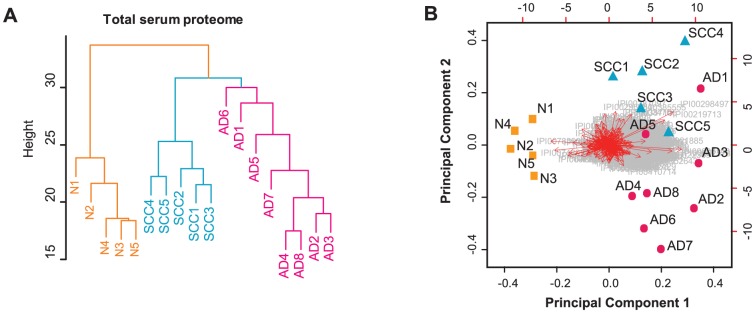
HCA and PCA of total serum proteomic data between samples.(A) Hierarchical clustering analysis and (B) Principal component analysis of all the 647 proteins quantified across the 18 serum samples. Ends of red arrows in (B) represent the PCA results for each protein.